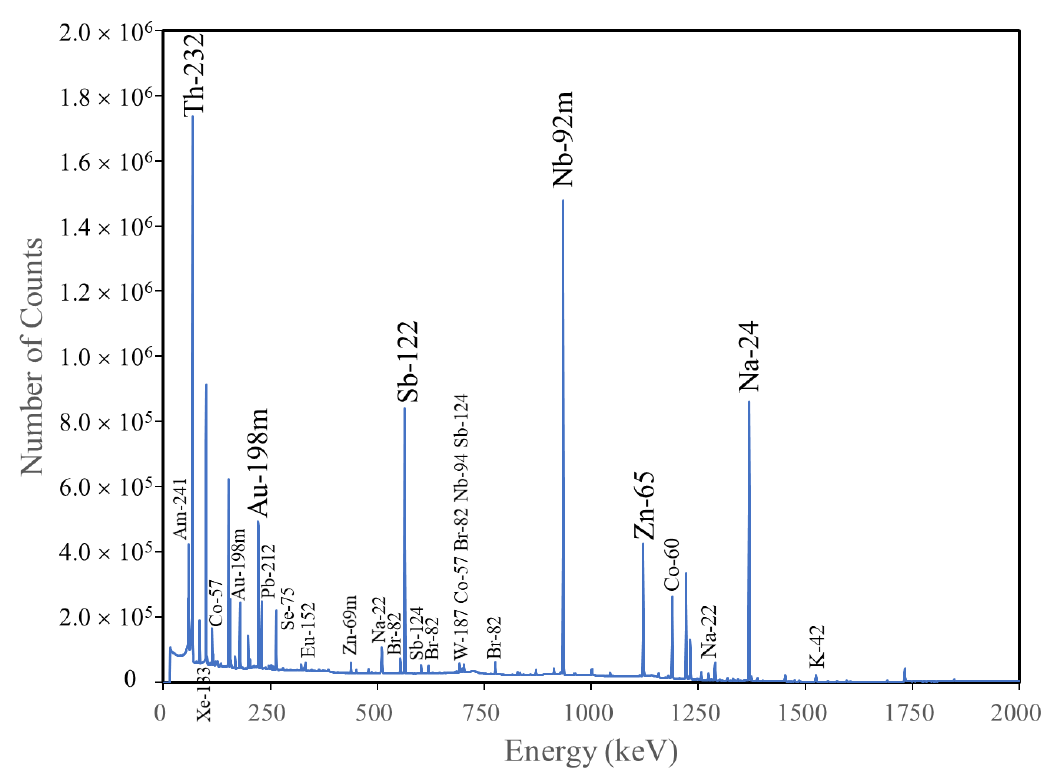
Figure 1. Gamma energy spectrum of a neutron-irradiated LiNbO 3 sample. A LiNbO 3 sample (12 mm × 8 mm × 1 mm; 0.45 g) was prepared and irradiated by neutrons for 2 h by THOR, where neutron fluence rate is about 10 12 cm − 2 s − 1 . After 24 h of cooling, the sample was measured using a high-purity germanium detector coupled with a multichannel analyzer and a software package.